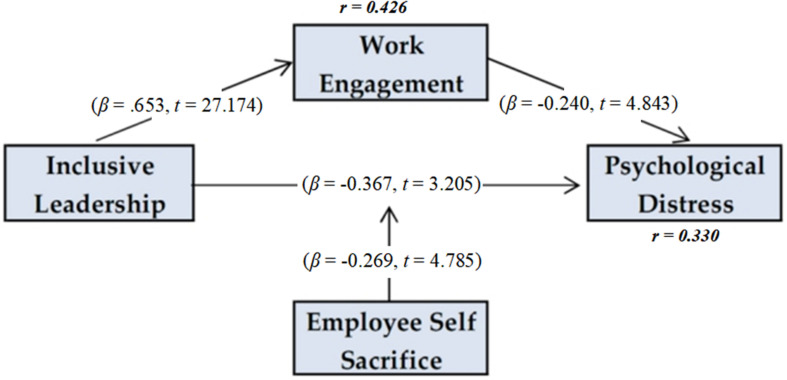
Results of the structural model.